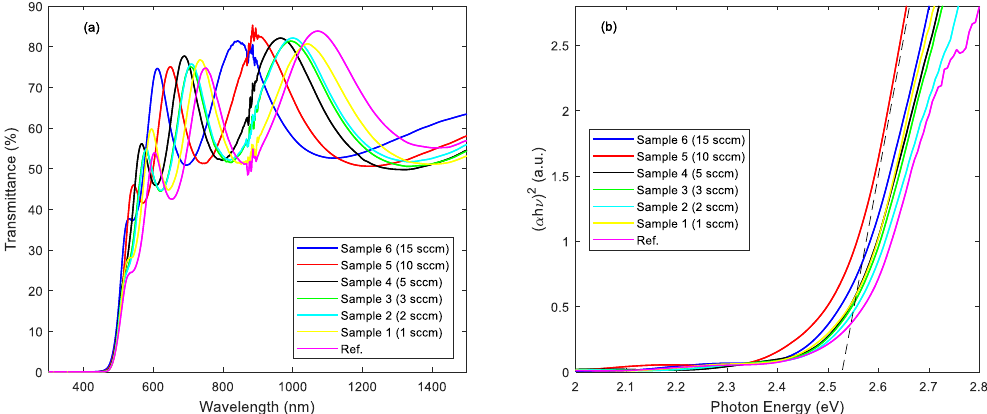
Figure 4. ( a ) Optical transmittance spectra and ( b ) corresponding Tauc plots for N:Cu 2 O thin films and Cu 2 O reference sample on quartz. The optical band gap energy for each sample was estimated from extrapolation to the abscissa (indicated by the dashed line).